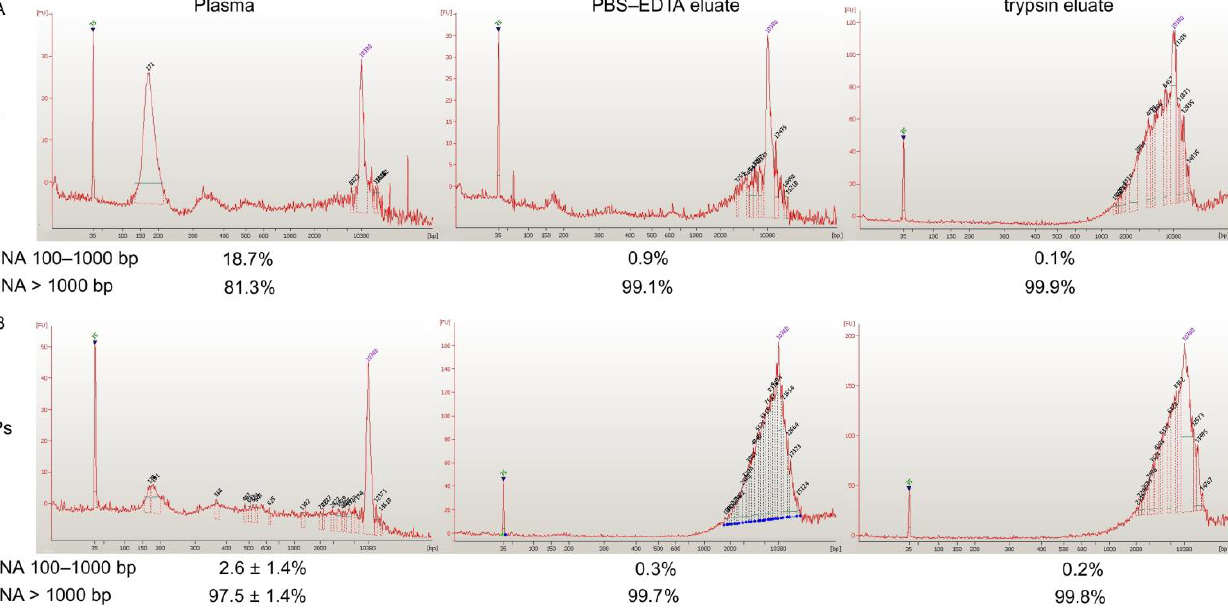
Table 1. RARβ2 index of methylation in the cirDNA from HFs and BCPs, mean ± SD *. Blood